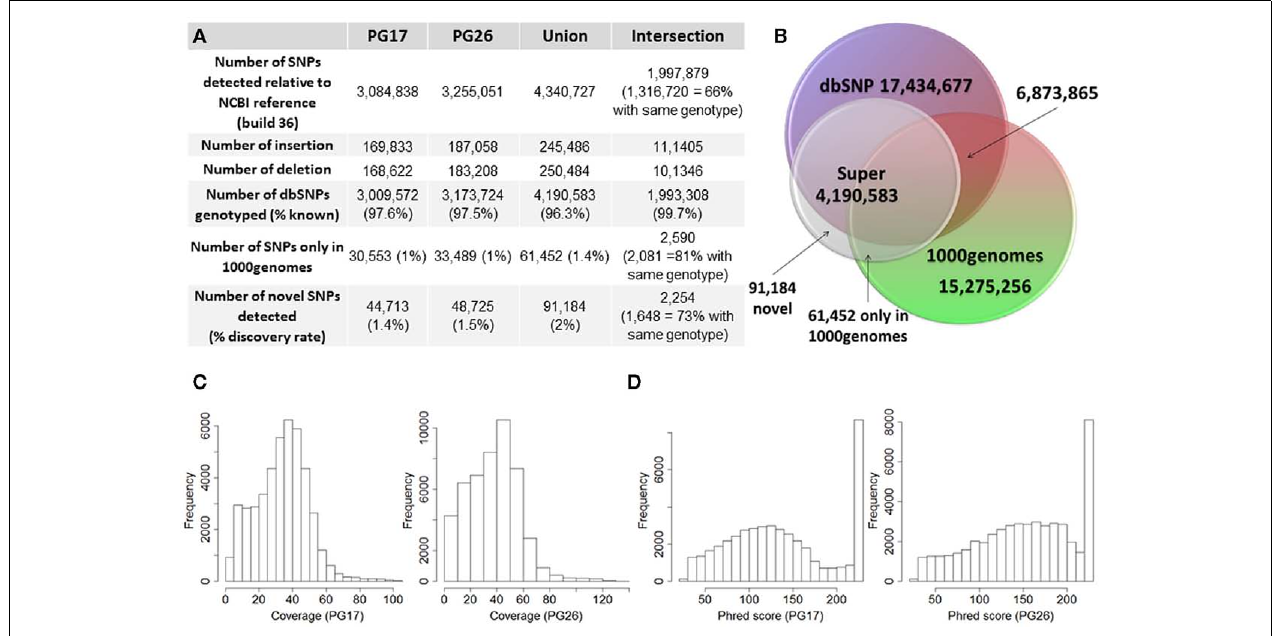
illustrates the proportion of known and novel SNPs in the woman (PG17) and man (PG26) combined. (C) Distribution of effective coverage (reads used to call genotypes in CASAVA) for novel SNPs. (D) Distribution of Phred scores for the novel SNPs.The Phred scores were computed with